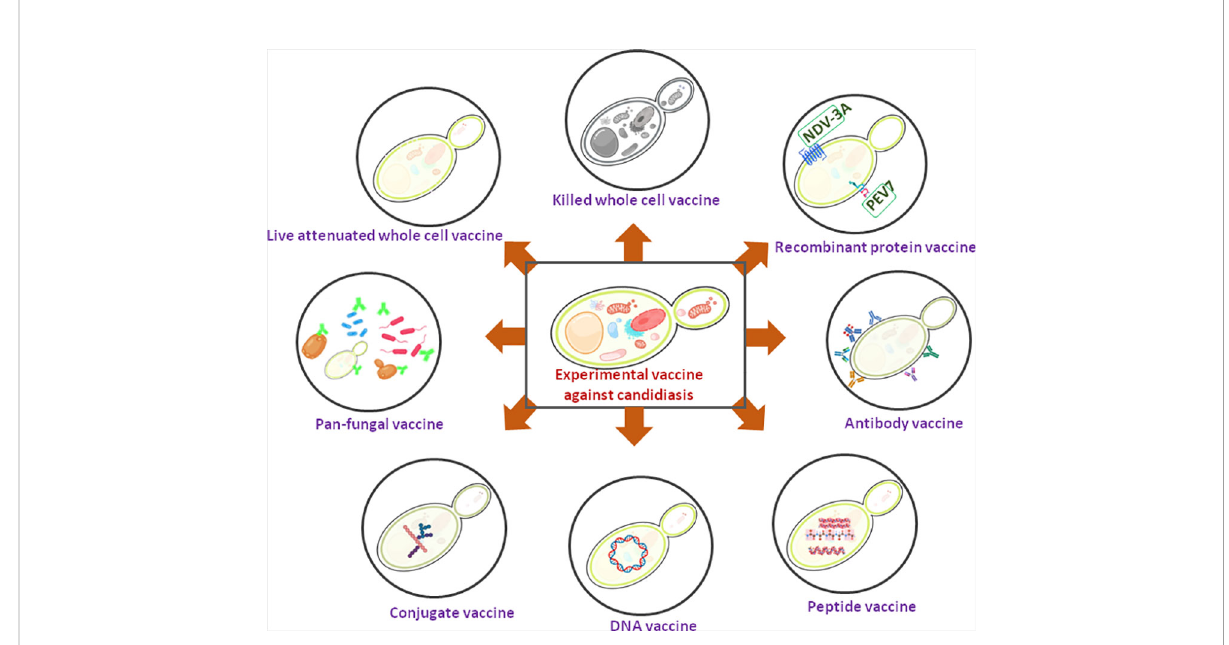
FIGURE 1 A schematic diagram showing experimental Candida vaccines. Two recombinant protein vaccines are under clinical trial (showing